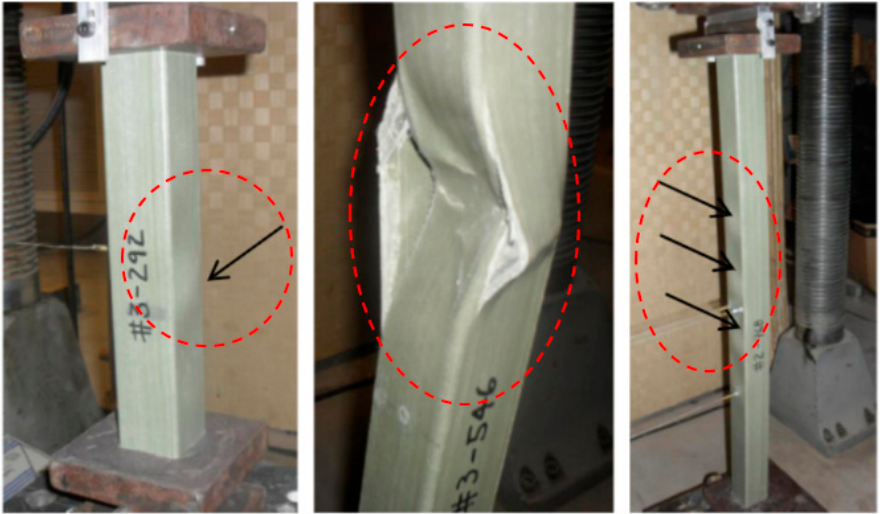
Figure 6. Failure observations (buckling) experienced by pultruded glass fiber-reinforced polymer composite (PGFRPC) square hollow tube.